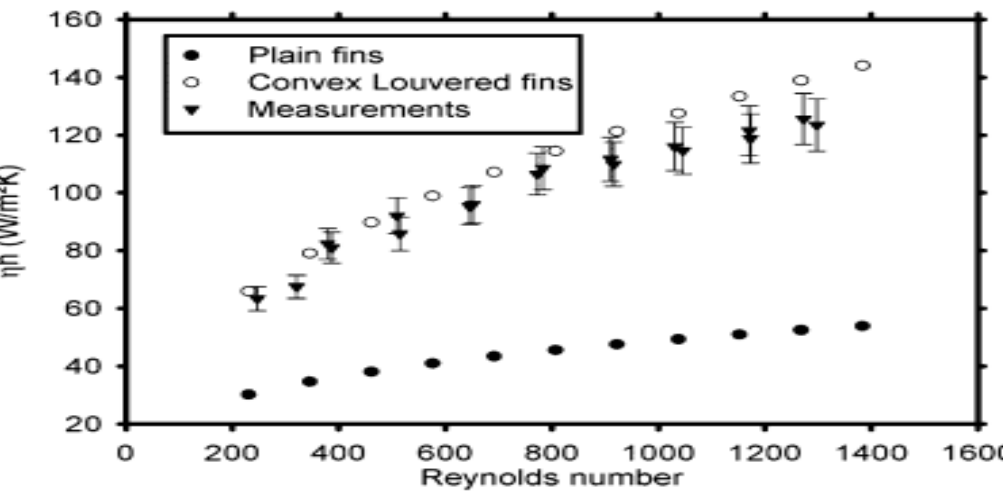
Figure 11: Reserved values of Colburn factor versus air side Reynolds number compared to forecast values by the correlation for plain fins and the correlation for convex louvered fins